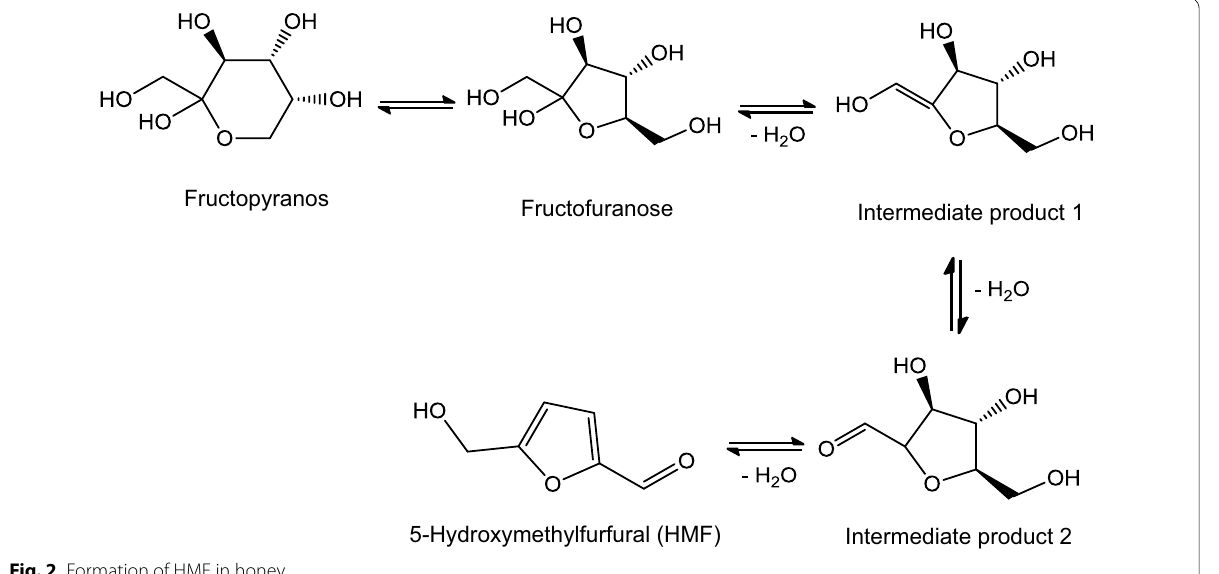
Fig. 2 Formation of HMF in